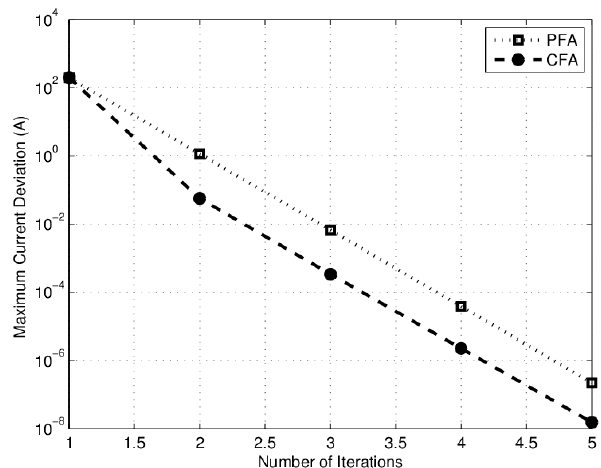
Figure 5. Maximum current deviation in log scale showing convergences of power flow analysis (PFA) and current flow analysis (CFA).